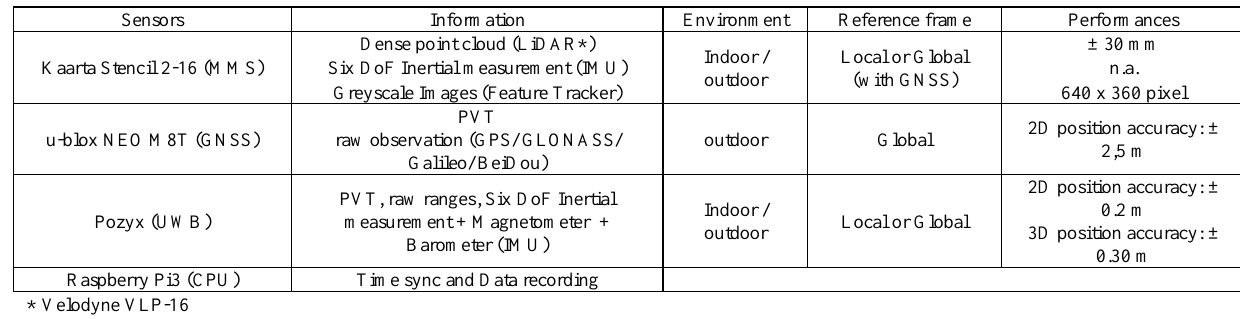
Table 1. Characteristics of the technologies, hardware and sensors used in the multi-sensor